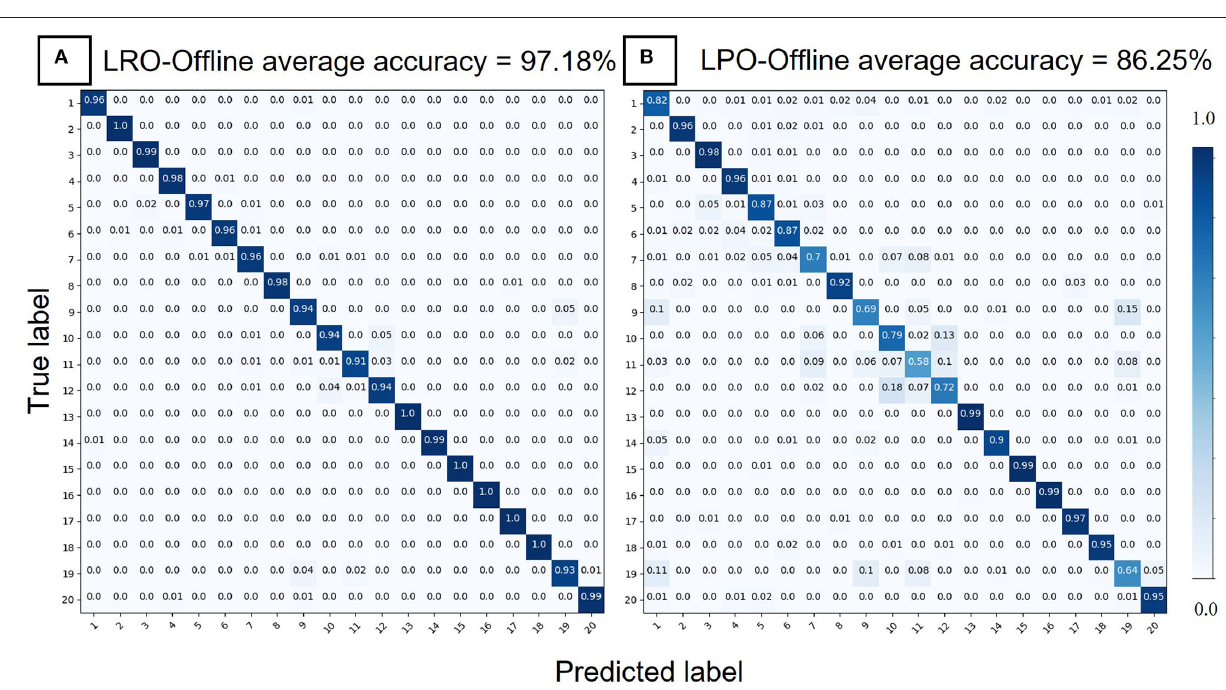
Frontiers in Computer Science |